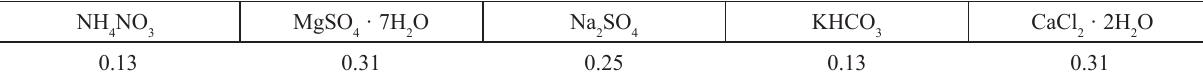
Table 1 – Chemical composition of the simulated acid rain solution, g L –1